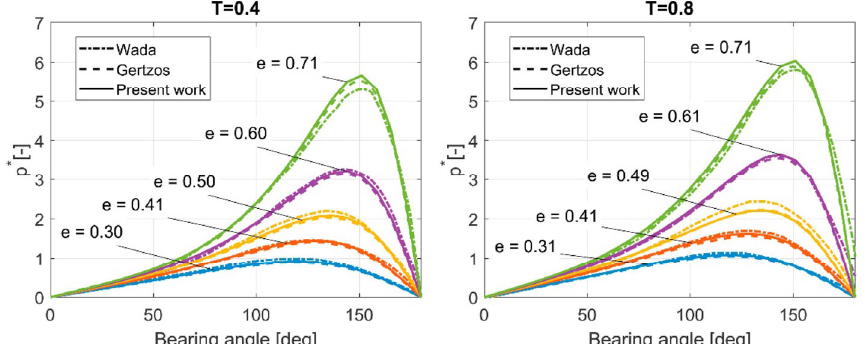
Fig. 56 Press curve comparison between present model and other two models [862]. Reproduced with permission from Ref.